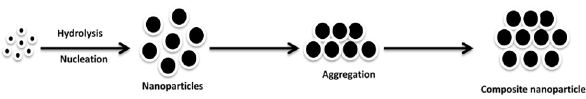
Figure 1. Schematic view for growth mechanism of composite nanoparticles.